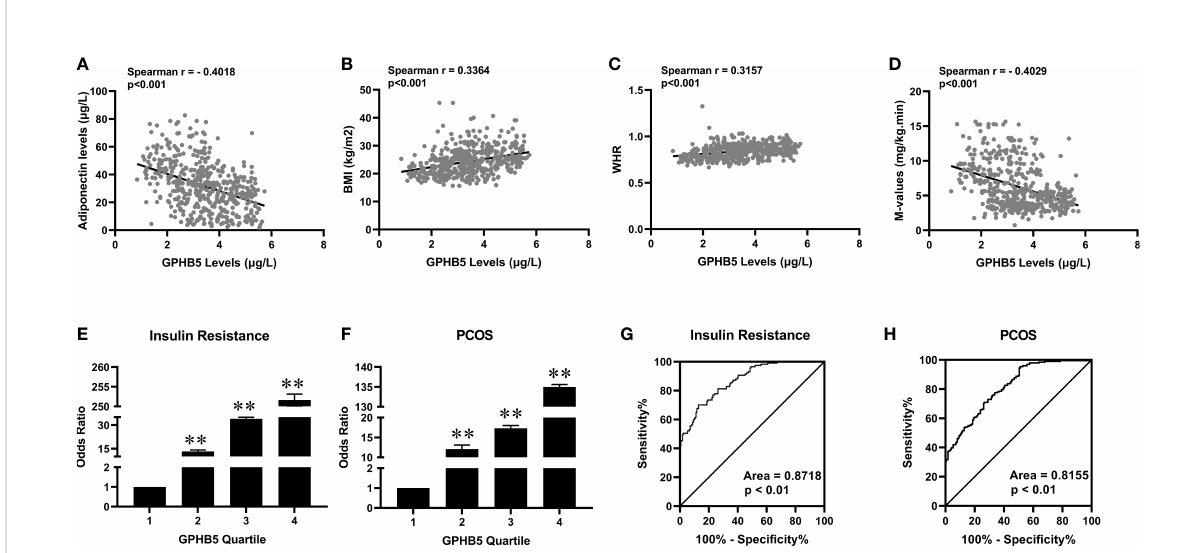
FIGURE 6 The relationship between GPHB5 and obesity, IR and PCOS in the study population. (A) Correlation between circulating GPHB5 and adiponectin. (B) Correlation between circulating GPHB5 and BMI. (C) Correlation between circulating GPHB5 and WHR. (D) Correlation between circulating GPHB5 and M-values. (E, F) The odds ratio of having IR (E) and PCOS (F) in different quartiles of circulating GPHB5. (G, H) ROC curve analyses for the prediction of IR (G) and PCOS (H) according to circulating GPHB5 levels. Data are means ± SD. ** p < 0.01. vs. quartile 1.